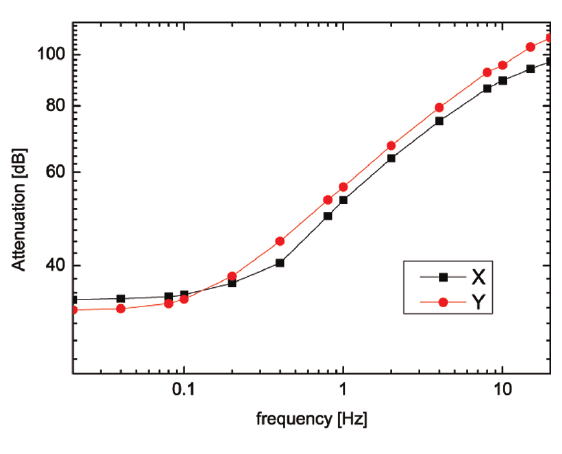
externally applied field in the frequency range 0.01–20 Hz, as a function of the frequency for the x (black line) and y (red line) directions. Passive shielding factors of 34.56 dB and 56.29 dB, at 0.1 Hz and 1 Hz, respectively, have been